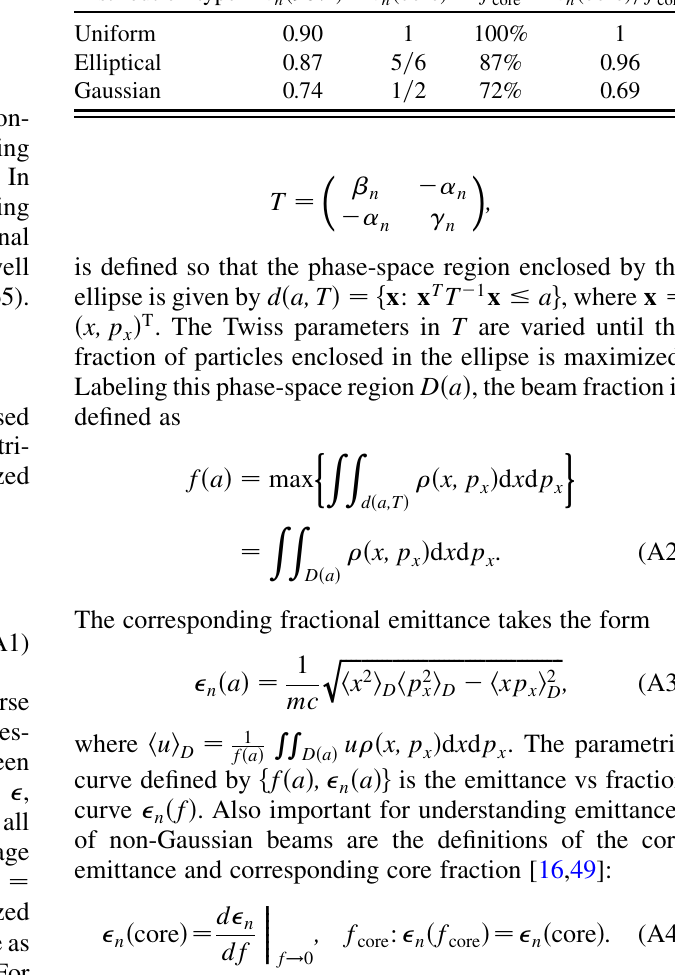
TABLE V. The scaled emittance and fraction data for various phase-space distributions. Distribution